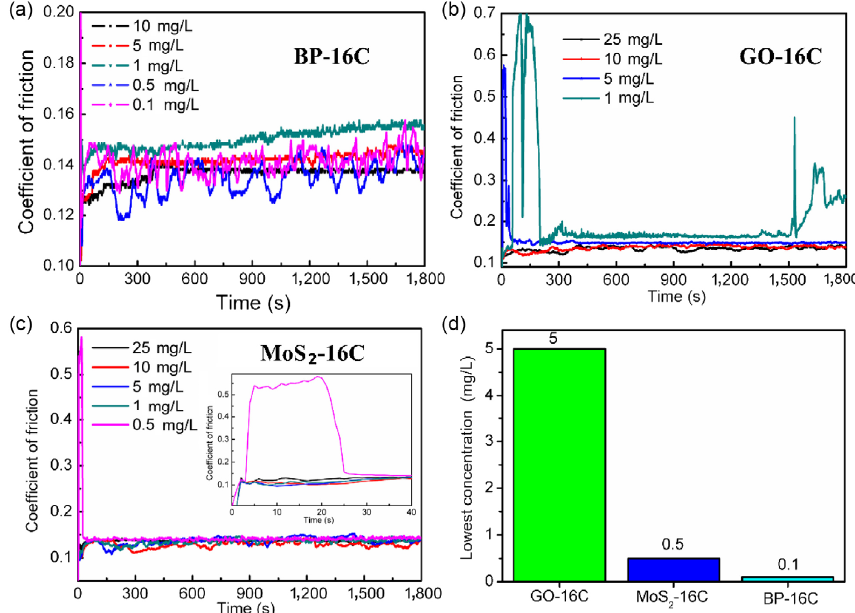
Fig. 19 Coefficients of friction (COF) of BP-16C at various concentrations: (a) COF of BP-16C below 10 mg/L; (b) COF of GO-16C below 10 mg/L; (c) COF of MoS 2 -16C below 10 mg/L; (d) Comparison of three oil-based lubrication additives at ultra-low